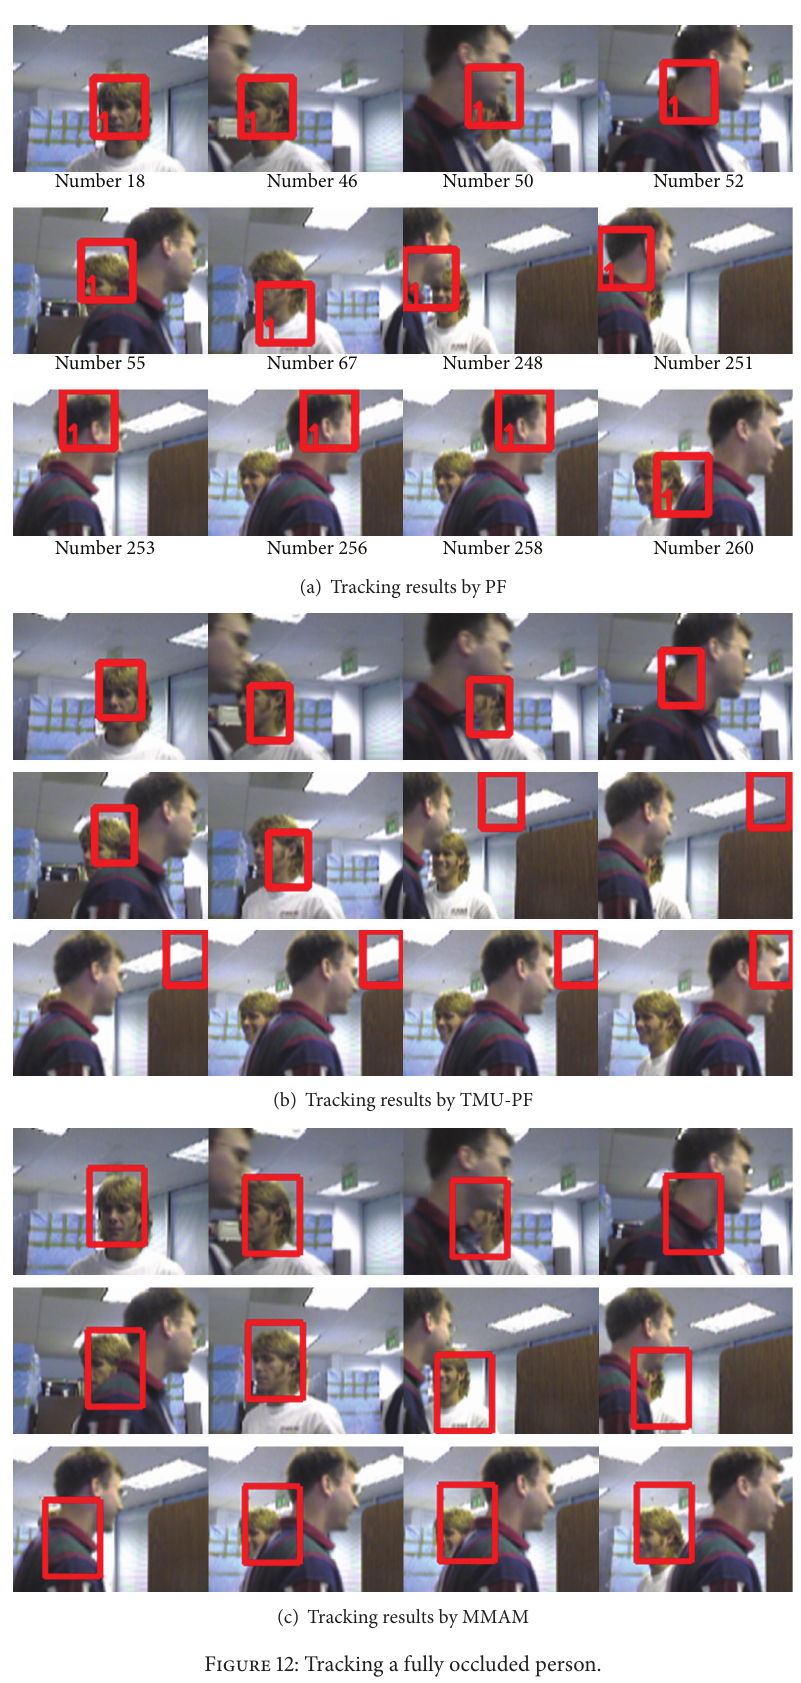
Figure 12: Tracking a fully occluded